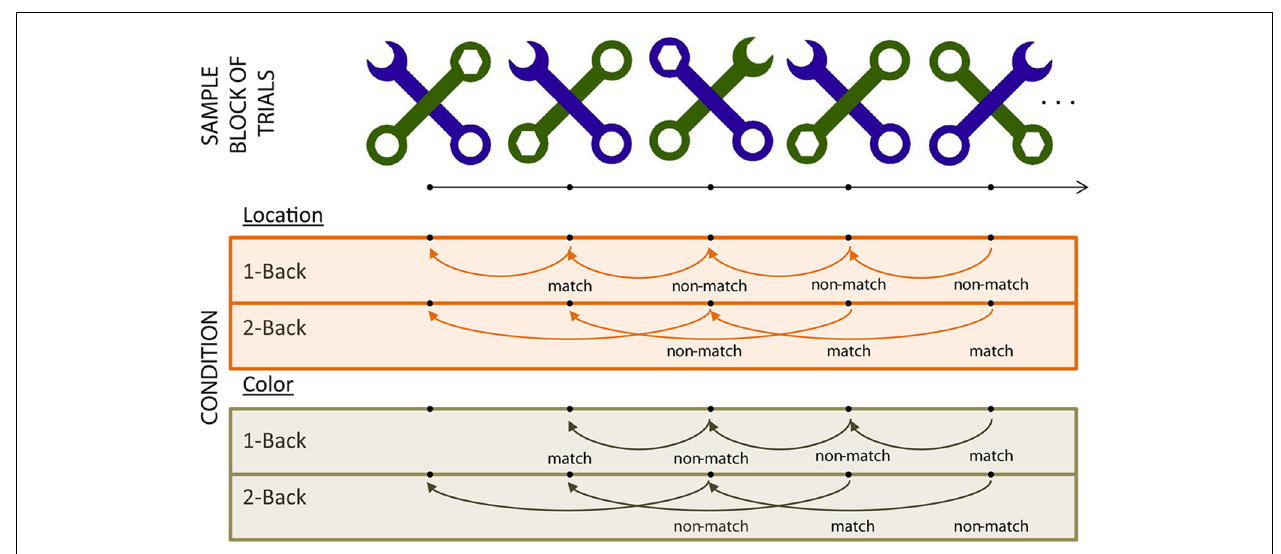
FIGURE 1 |Task schematic (see Stimuli and Experimental Design)